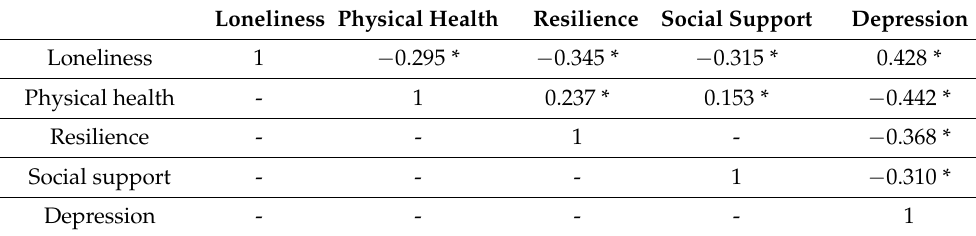
Table 2. Results of correlation tests between the measured variables ( n =